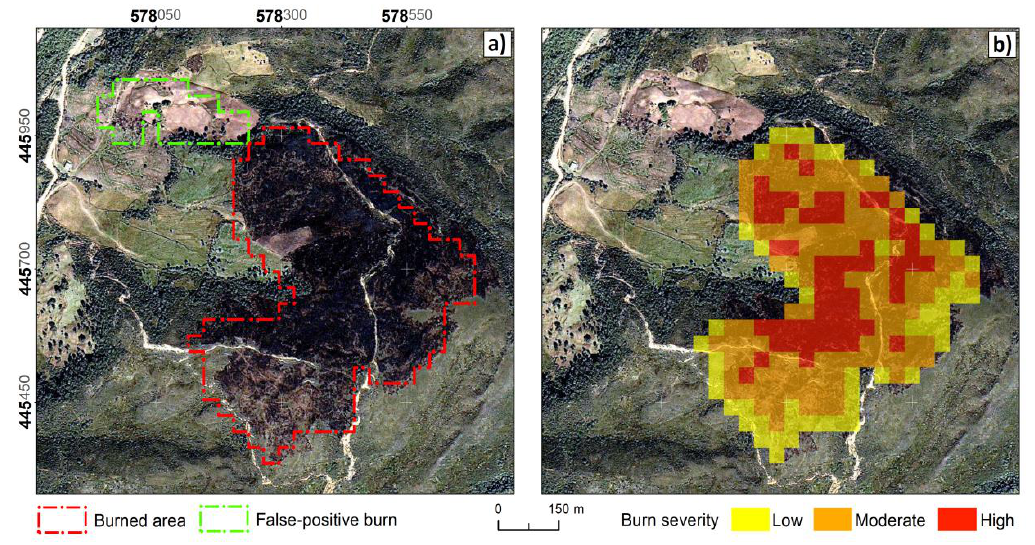
Figure 8. Example of the detected burned area ( a ) Polygons obtained as the final outcome of the overall procedure where the false-positives were filtered out by on-screen visual interpretation. ( b ) The burn severity obtained from the